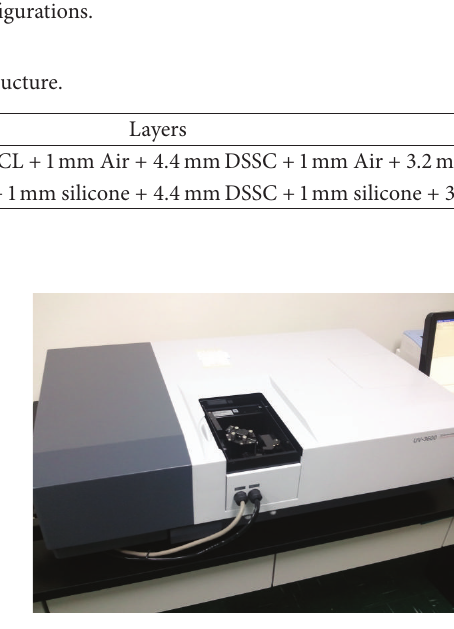
Figure 4: UV-Vis spectrophotometer.